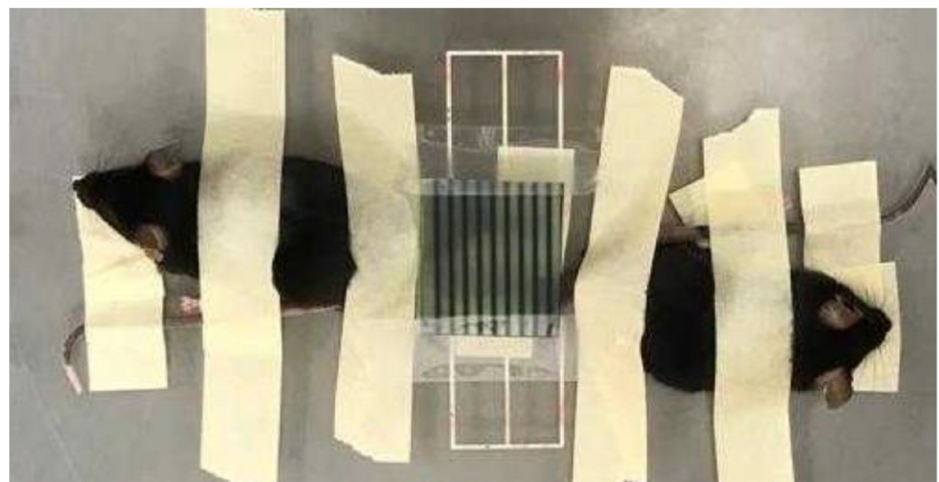
Figure 4. Irradiation setup: the gachromic film shows the pattern of the irradiation. The animals were followed up for four weeks. The skin reaction was scored every two to three days using the arbitrary score that is shown in Table 1, which is inspired by previous work on mouse skin irradiations